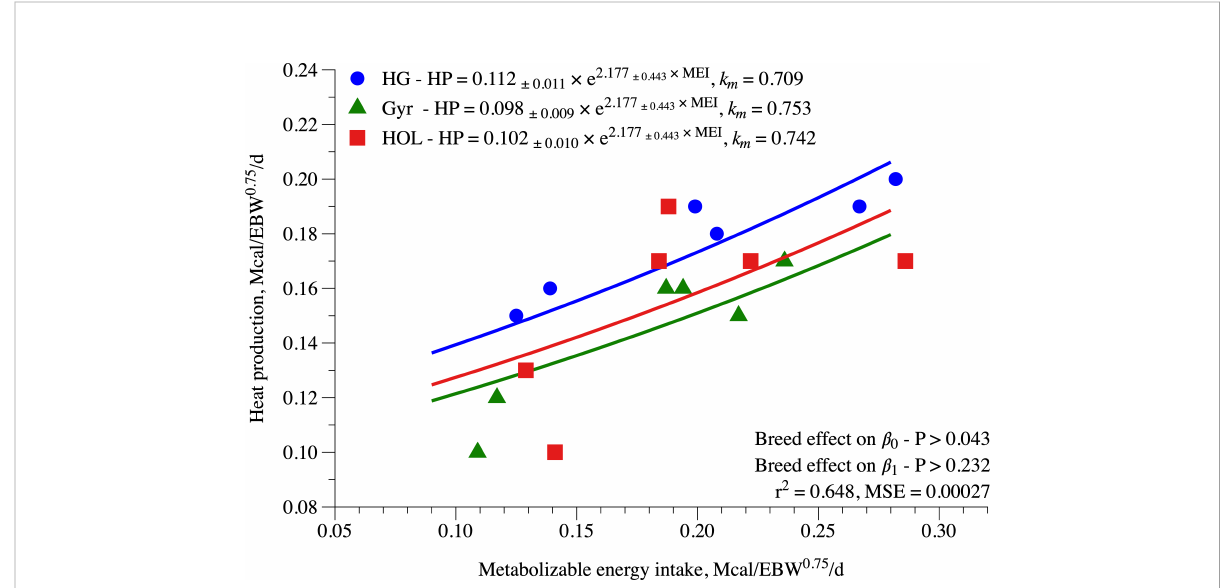
FIGURE 1 Prediction equation of the net energy requirements (NEm; Mcal/day) of dairy heifers of three breed compositions (BC) fed at three feeding